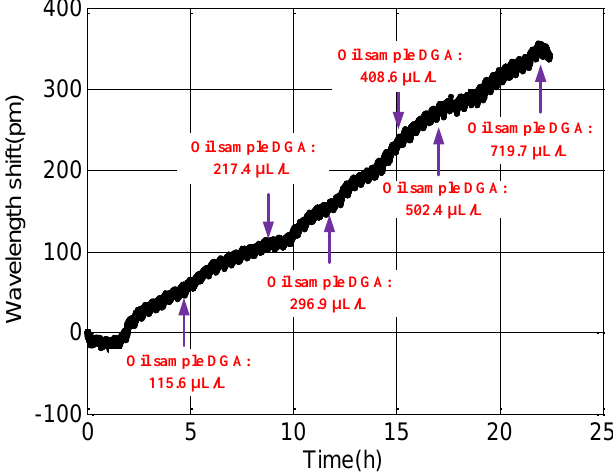
Figure 7. Wavelength shifts and DGA values of oil samples at different times. Sensors 2016 , 16 , 1641